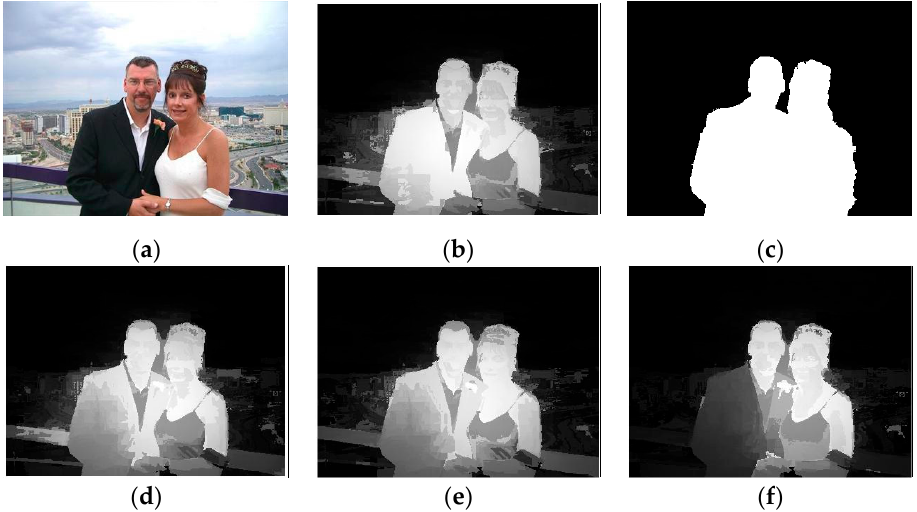
Figure 2. Saliency map comparison. ( a ) Image; ( b ) tensor decomposition original (TDO) saliency map (with sub-problem solutions integrated); ( c ) ground-truth saliency map; ( d ) sub-problem 1 saliency map; ( e ) sub-problem 2 saliency map; ( f ) sub-problem 3 saliency map.